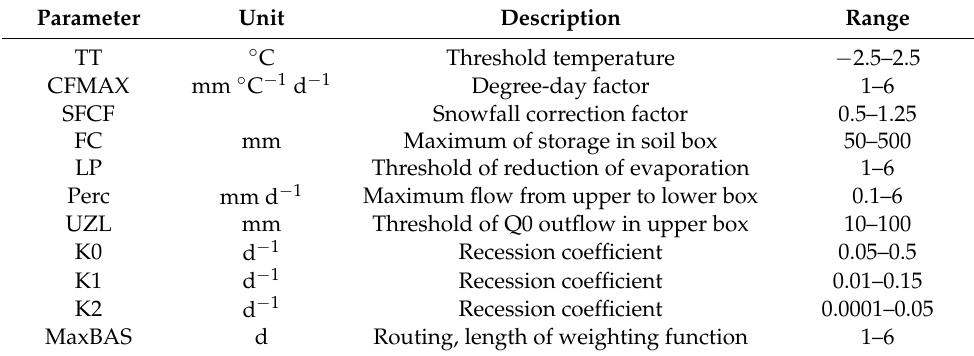
Table A4. Suggested range for the calibration parameters of the HBV model.